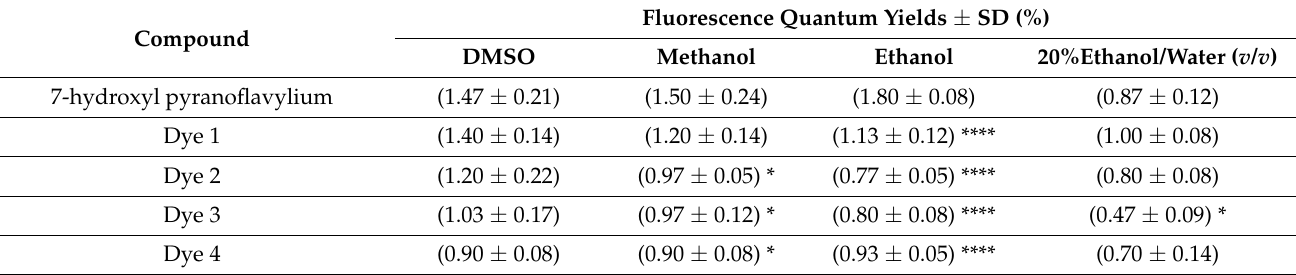
Table 3. Fluorescence quantum yields for the different compounds determined by the absolute method using an integrating